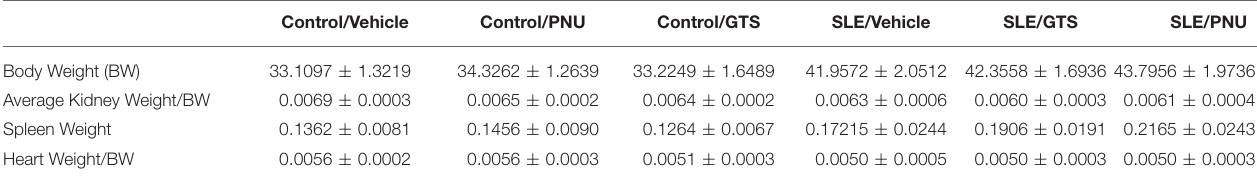
TABLE 1 | Body and tissue weights (in grams) for control and SLE mice treated with either vehicle, GTS-21, or PNU-120596.